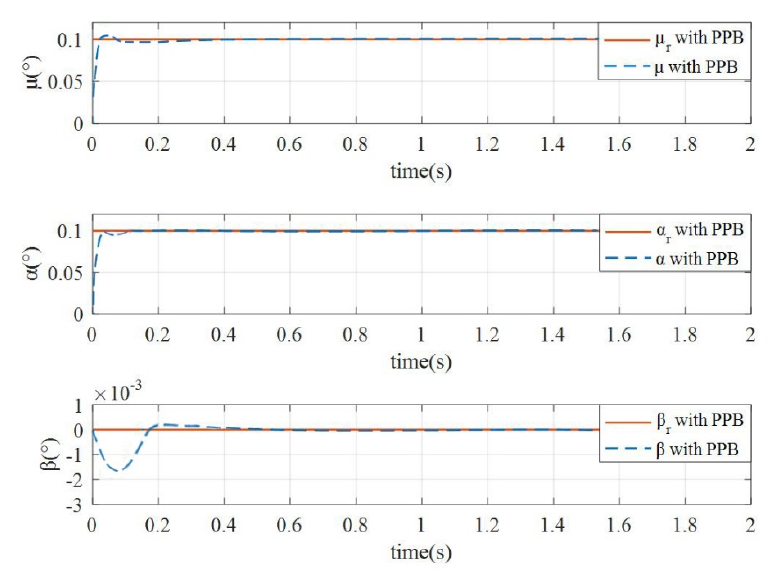
Figure 16. Tracking response of p , q and r without PPB.